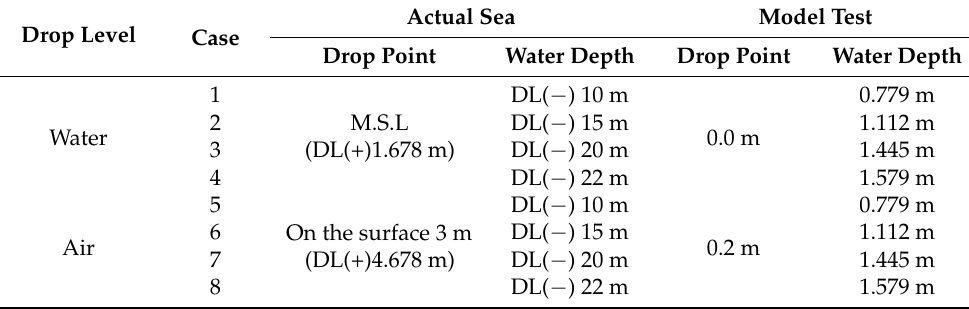
Table 5. Experimental